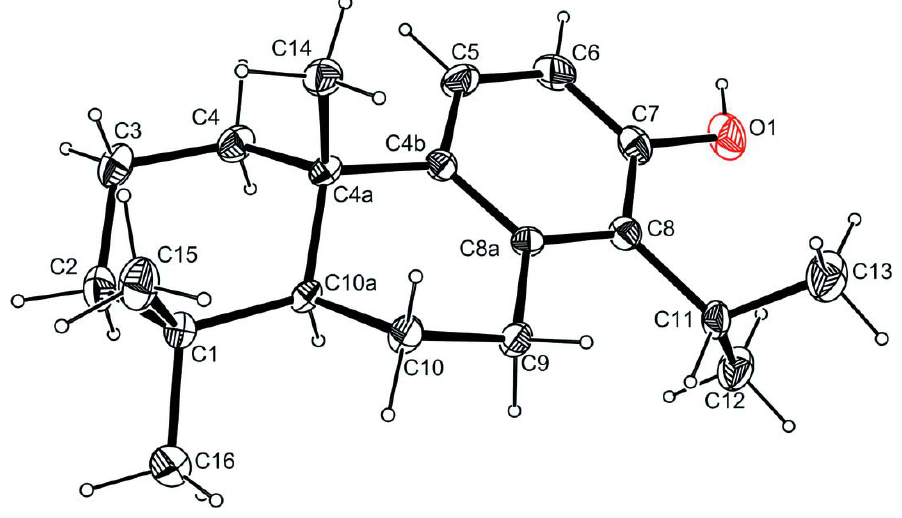
Molecular view of one of the four molecules of the title compound with the atom-labelling scheme. Ellipsoids are drawn at the 30% probability level. H atoms are represented as small spheres of arbitrary